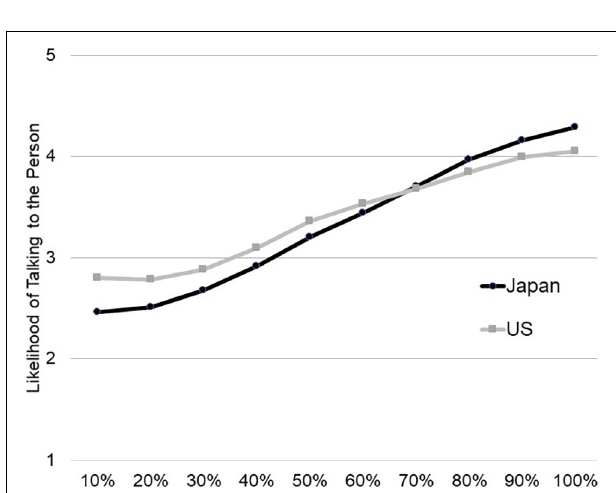
FIGURE 2 | Japanese are less likely than Americans to assist a person sitting on the street in an ambiguous situation, but the difference diminishes and reverses as the likelihood of the person being sick increases from 10% certain to 100% certain (Study 2).